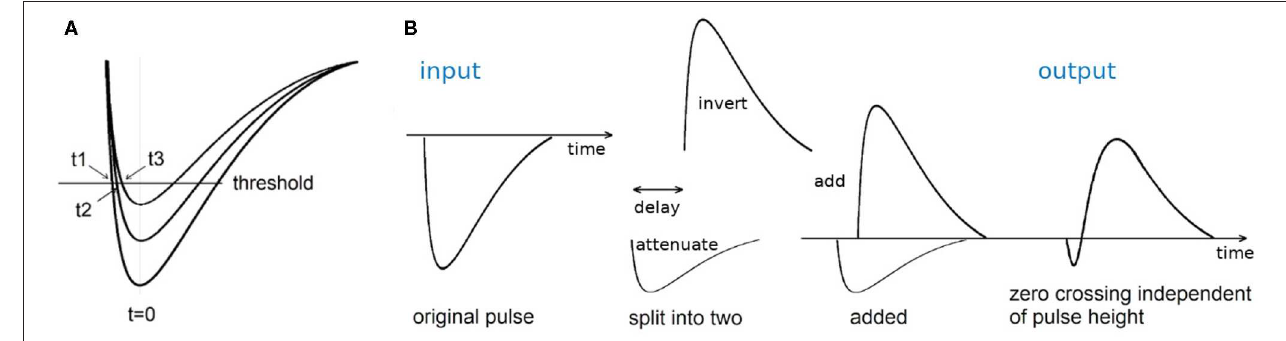
FIGURE 8 | (A) Schematic of leading edge discrimination. The fixed threshold times the pulses (all arriving at the same time t = 0) at different times t1, t2, and t3, depending on the pulse height. (B) Schematic of constant fraction discrimination. The original input pulse is split into two, one is attenuated, and one is delayed and inverted. The zero-crossing when the two pulses are added is independent of the pulse